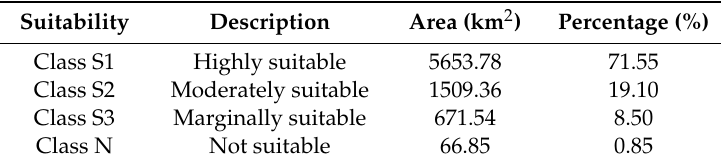
Table 3. Land suitability based on proximity to the